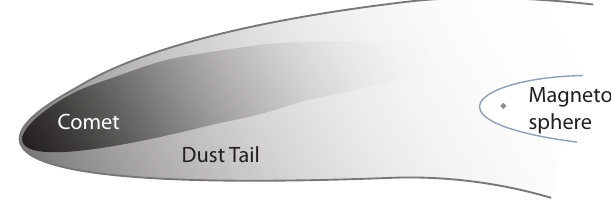
Fig.1. Schematicofthemagnetosphereembeddedintoawidecometarydusttail. Fig. 1. Schematic of the magnetosphere embedded into a wide r mp ∼ 8 R E or even r mp ∼ 6 R E unrelated to either kind of cometary dust such obvious events remained unexplained.